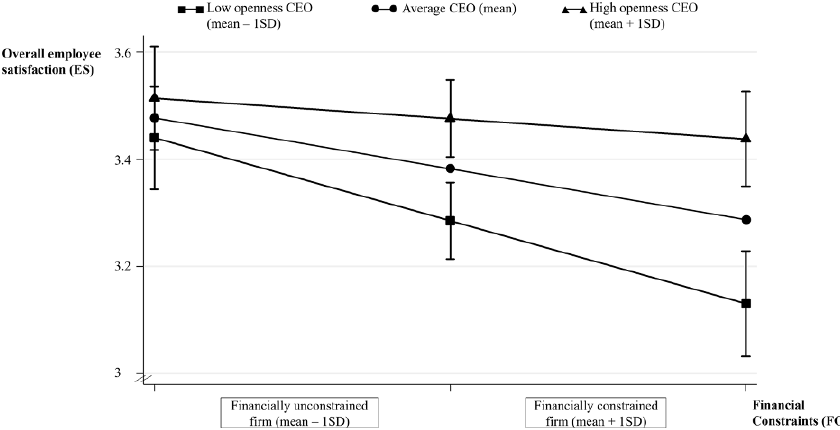
Fig. 3 Moderation effect of CEO openness to experience on the relation between financial constraints and employee satisfaction (H1), displaying 95% confidence intervals for high and low levels of CEO